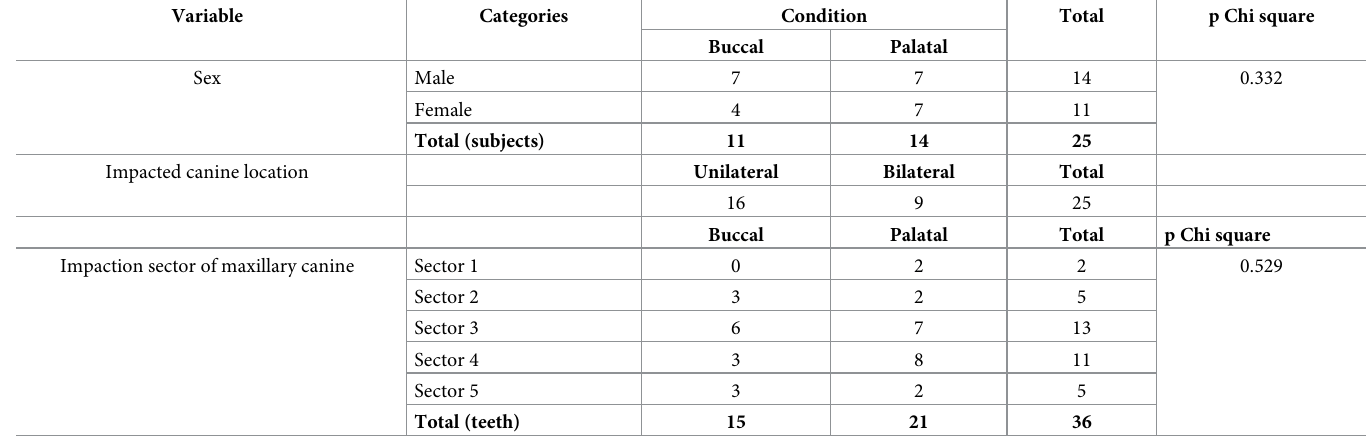
Table 1. Initial characteristics of the patients according to sex and impaction canine location and evaluation of the sector of impaction in buccal or palatal